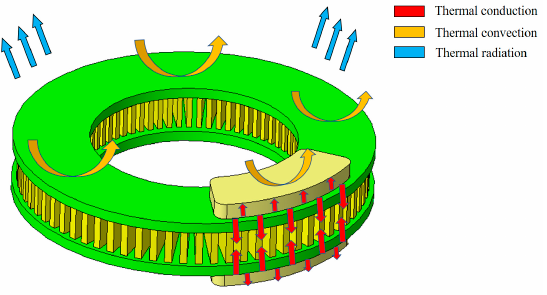
Figure 2. Three heat transfer forms of the brake pad and the brake disc.